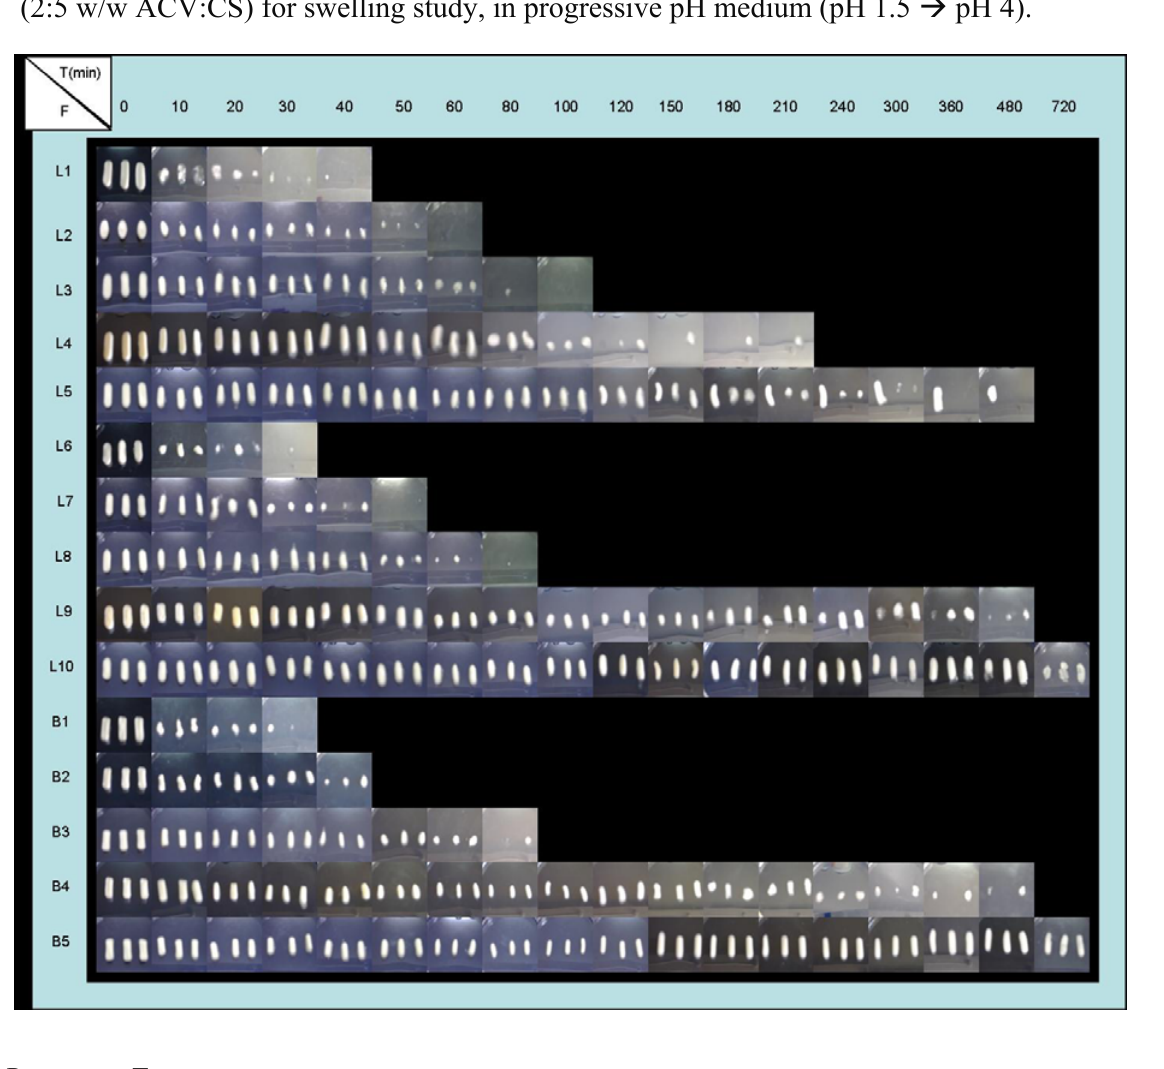
Figure 4. Evolution of freeze-dried formulations (F) B1 (1% CS), B2 (2% CS), B3 (3% CS), B4 (4% CS), B5 (5% CS), L1 (0.5:1 w/w ACV:CS), L2 (0.5:2 w/w ACV:CS),